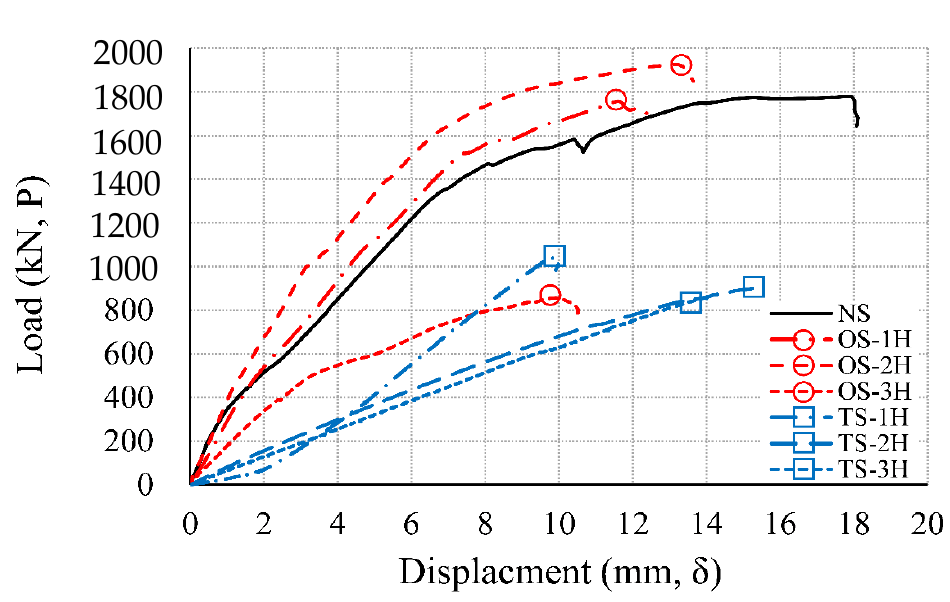
Figure 13. Load – displacement relationship (NS, TS specimen).